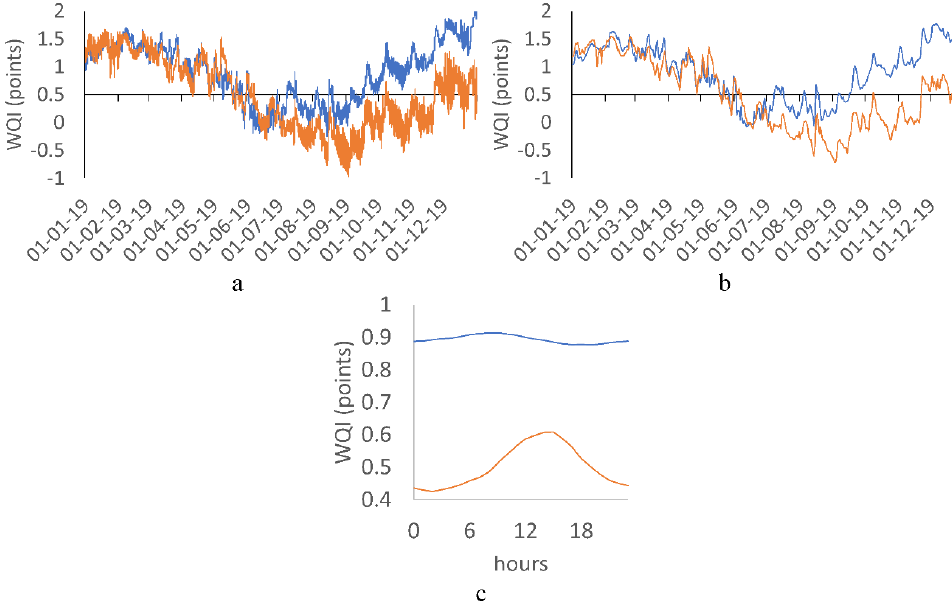
Figure 7. Water quality index (WQI) of Suceava River upstream (blue line) and downstream (orange line) in 2019: ( a ) temporal evolution based on hourly data; ( b ) temporal evolution based on average daily data; ( c ) average diurnal profile.